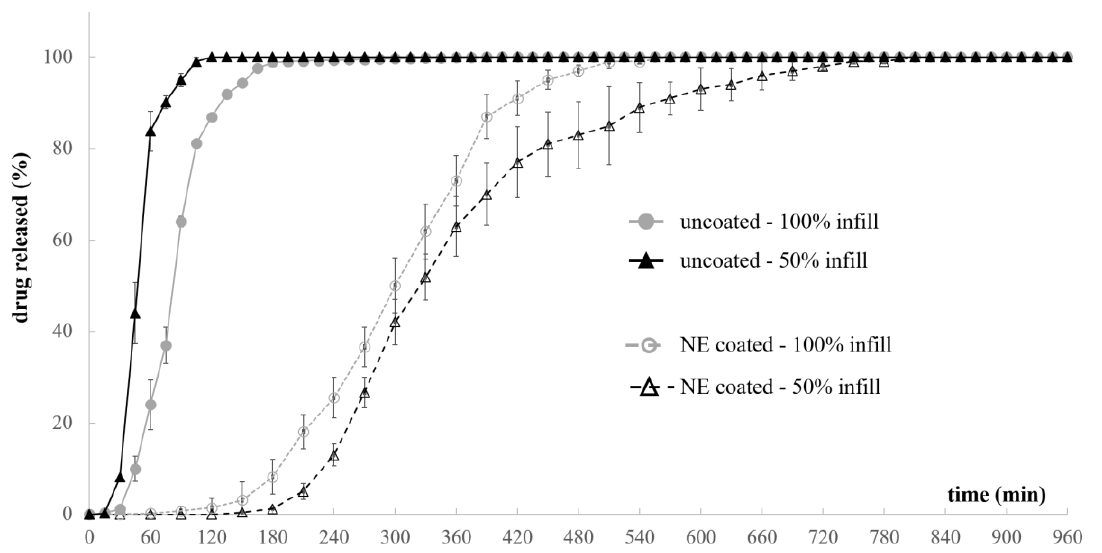
Figure 10. Release profiles relevant to uncoated and coated prototypes printed with different infill.